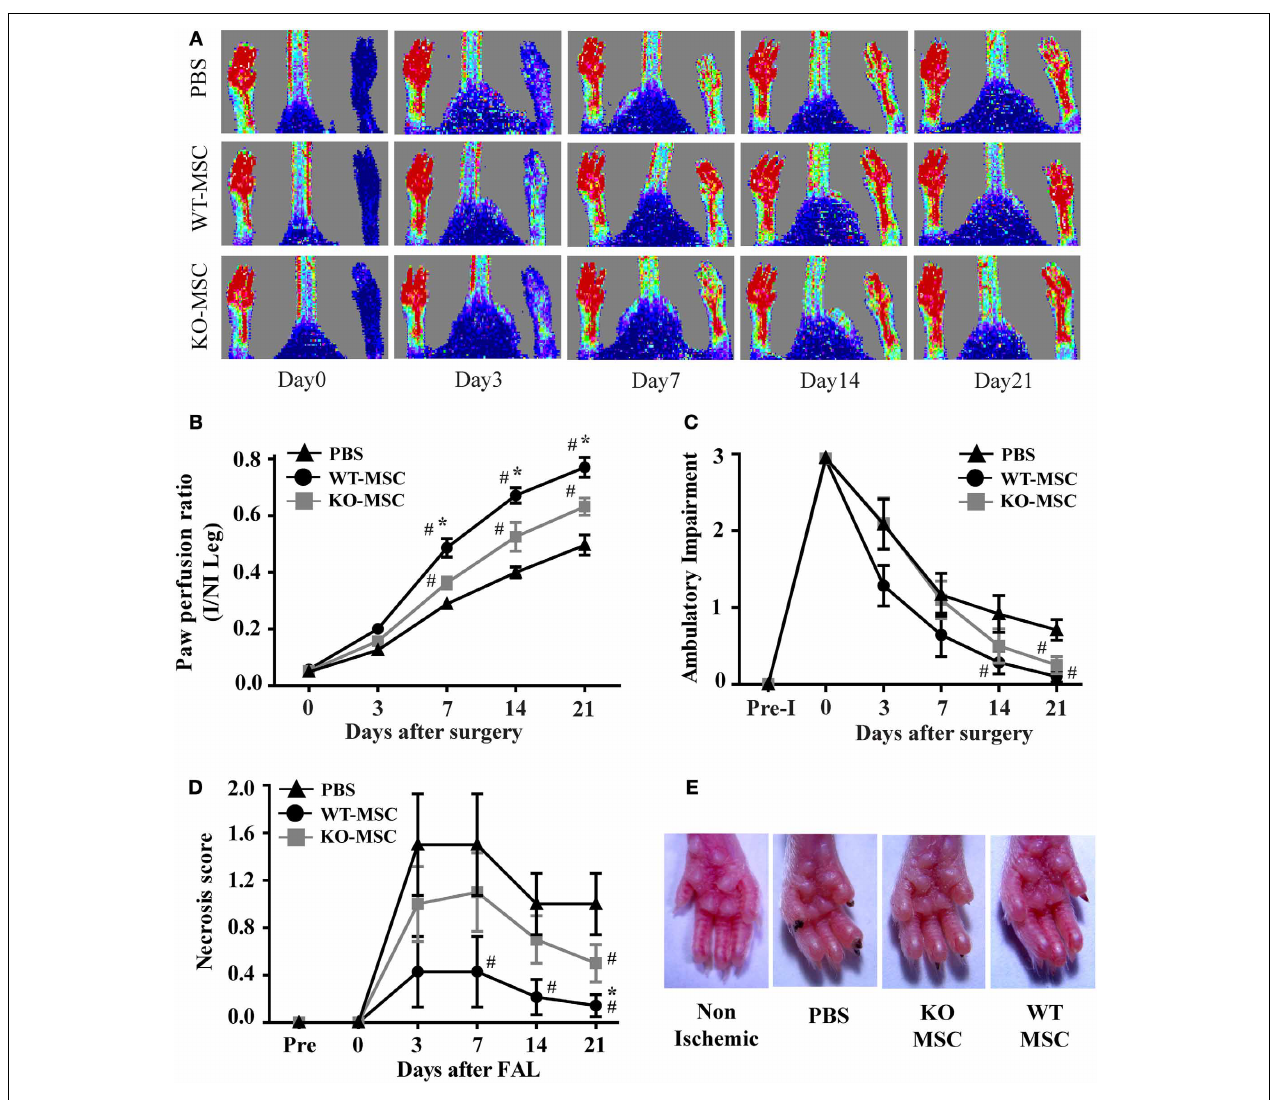
FIGURE 5 | Lack of CD13 on exogenously administered MSCs impairs perfusion recovery in an in vivo hindlimb ischemia model. (A) Laser Doppler flow imaging of perfusion in mice at the indicated time points. Representative color-coded images of three groups (PBS, WT-MSC, and KO-MSC) of mice on day 0, 3, 7, 14, and 21 after surgery and cell transplantation assessed by laser Doppler imaging. Red indicates highest perfusion velocity, green intermediate, and blue, lowest velocity. (B) Cumulative results for PBS ( n = 7), WT-MSC ( n = 6), and KO-MSC ( n = 6)